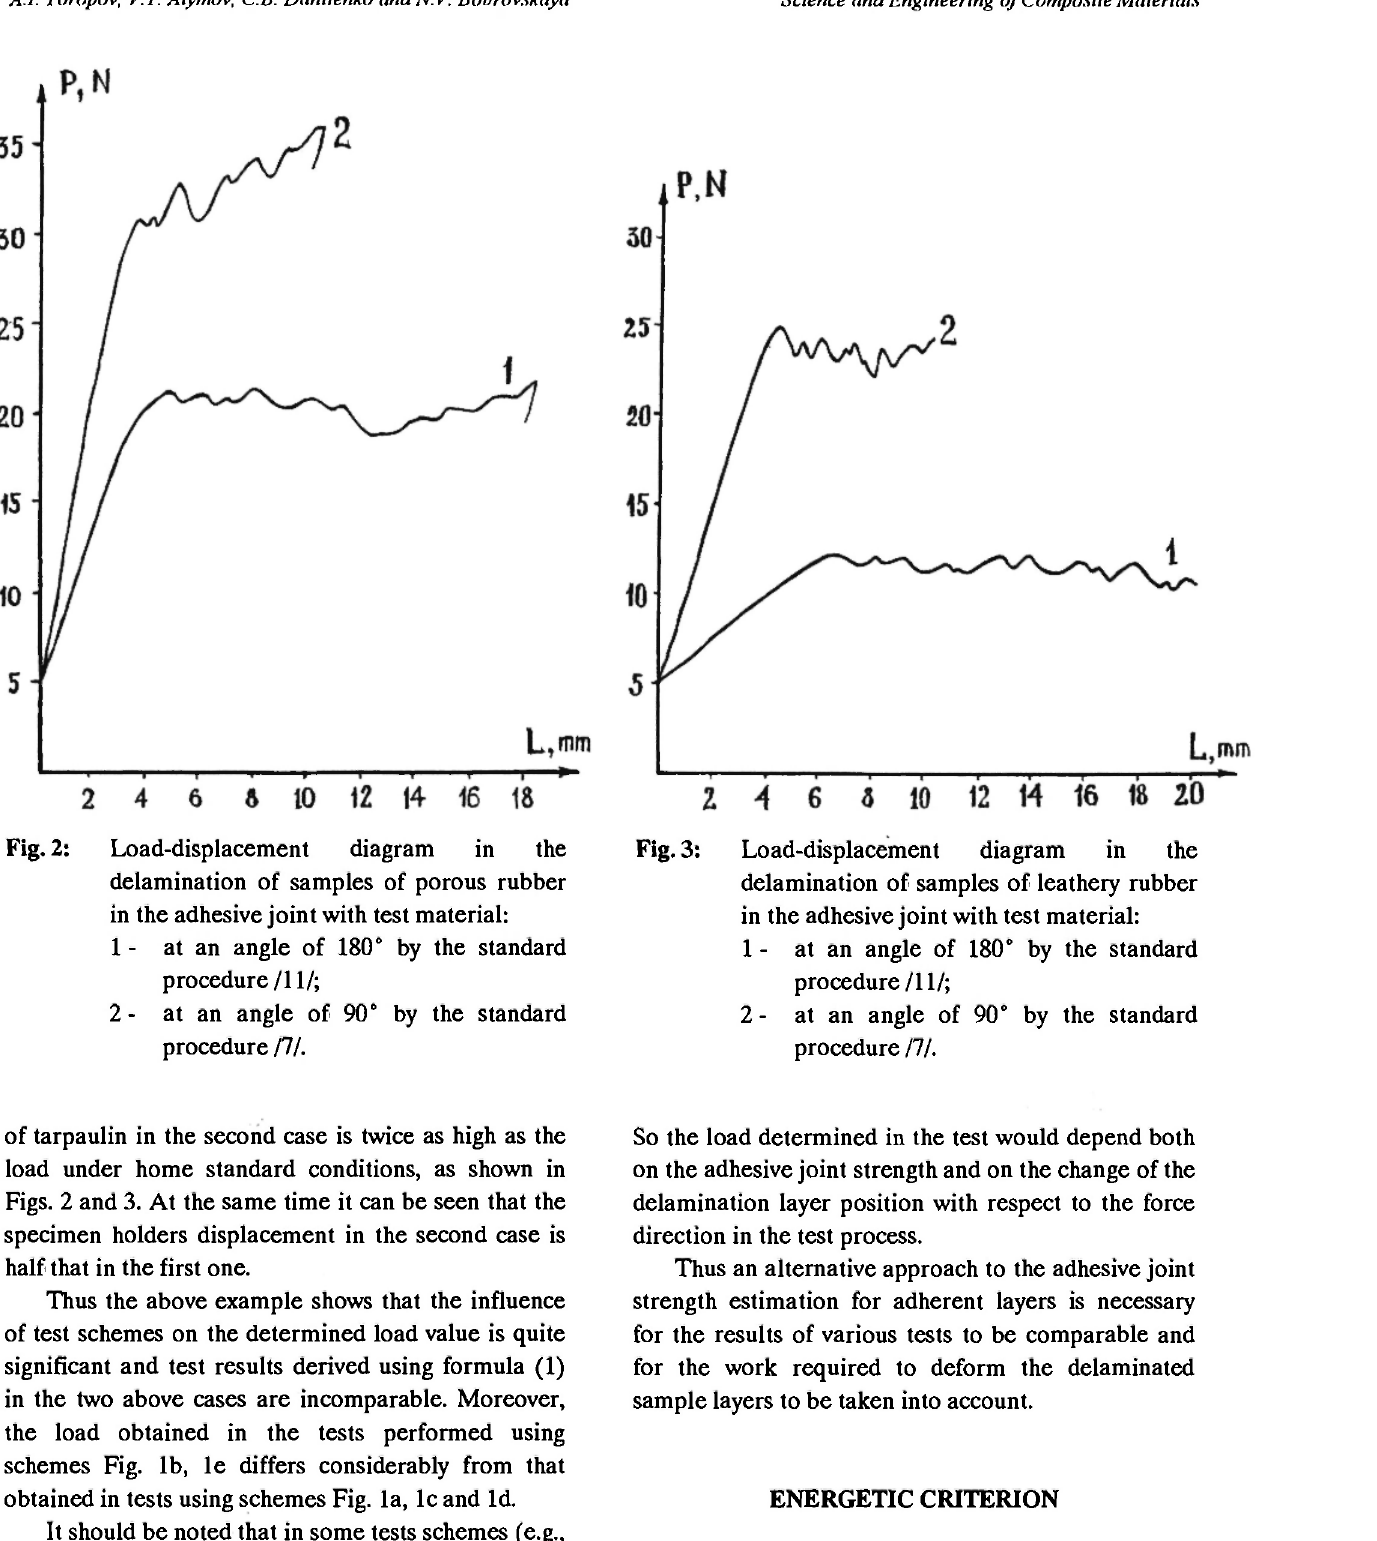
Fig. 2: Load-displacement diagram in the delamination of samples of porous rubber